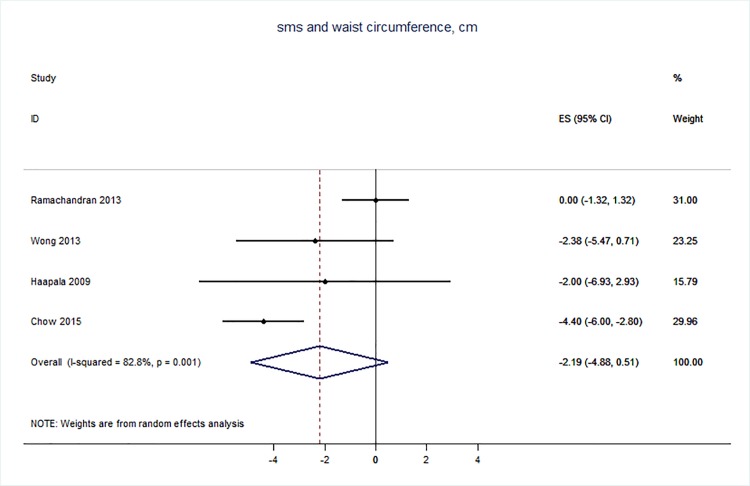
Physical activity and diet interventions using SMS function–waist circumference endpoint (cm).